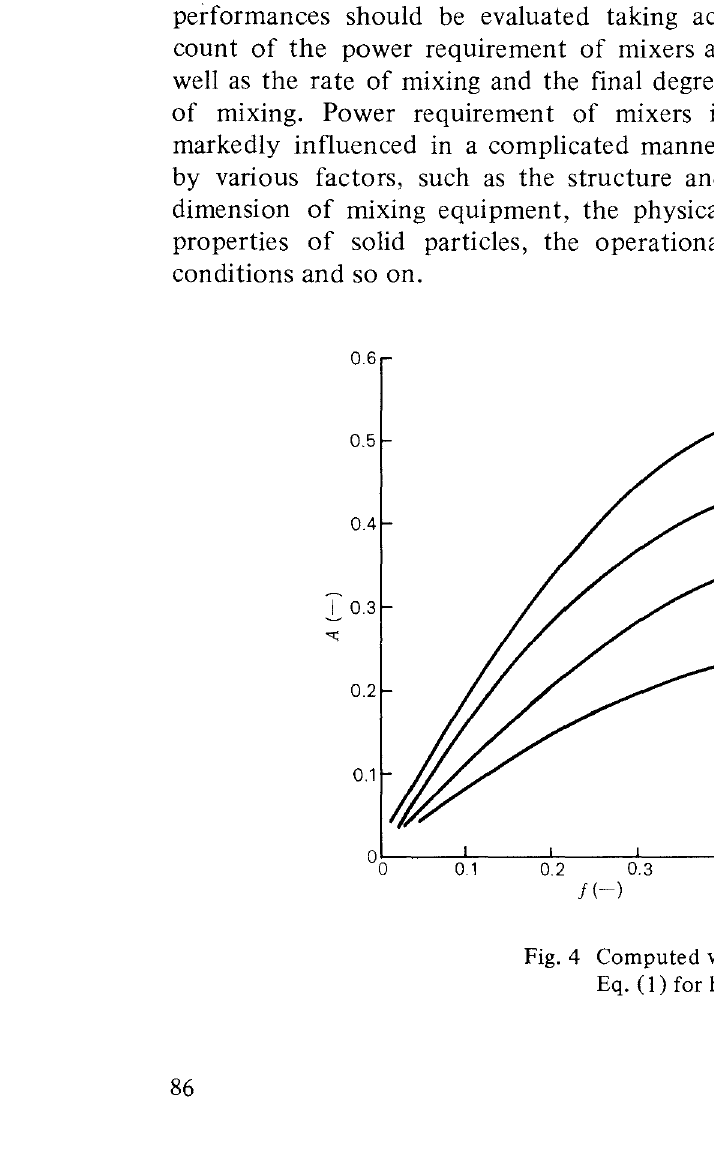
Fig. 4 Computed values of coefficients A and B in Eq. (1) for horizontal cylindrical